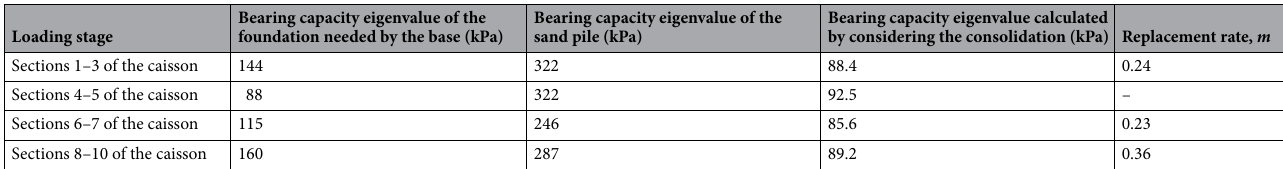
Table 5. Calculation of the replacement rate.